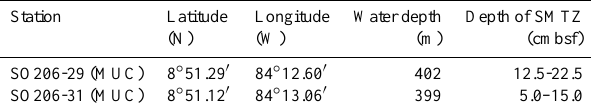
Table 1. Sampling sites of the Quepos Slide and the SMTZ depth in centimeters below seafloor